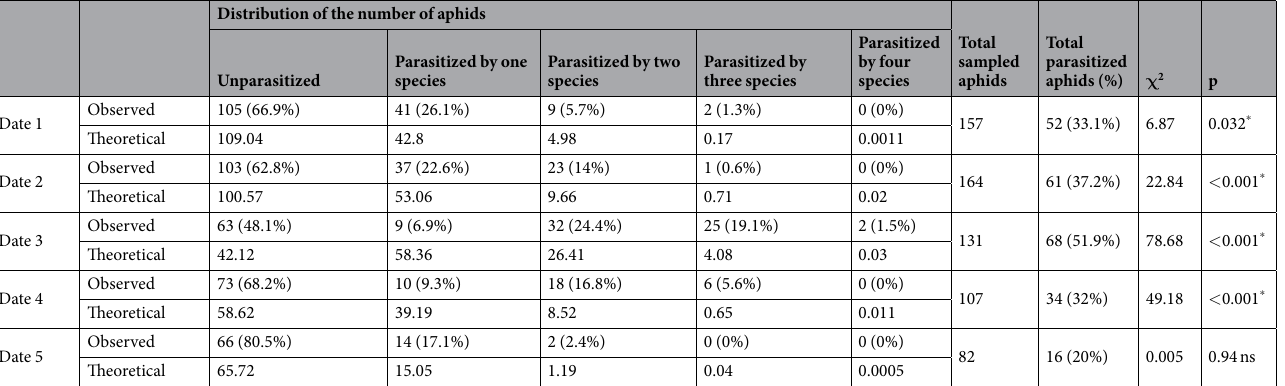
Table 1. Comparison of the total number of the observed and theoretical (random acceptation of multiparasitized hosts) distribution of the number of aphids per each sampling date considering the number of aphids parasitized by one, two, three or four different species and unparasitized aphids. * Denotes statistical differences and ns denotes non-statistical differences based on the t- test on proportion analyses at p < 0.05.